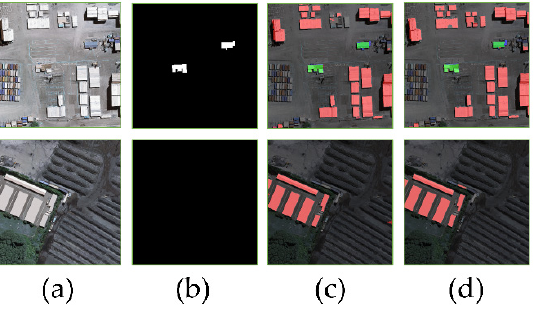
Figure 16. Examples of error extraction. ( a ) Original images, ( b ) labels, ( c ) U-Net, ( d ) B-FGC-Net. The green and red indicate the correct and incorrect, respectively.